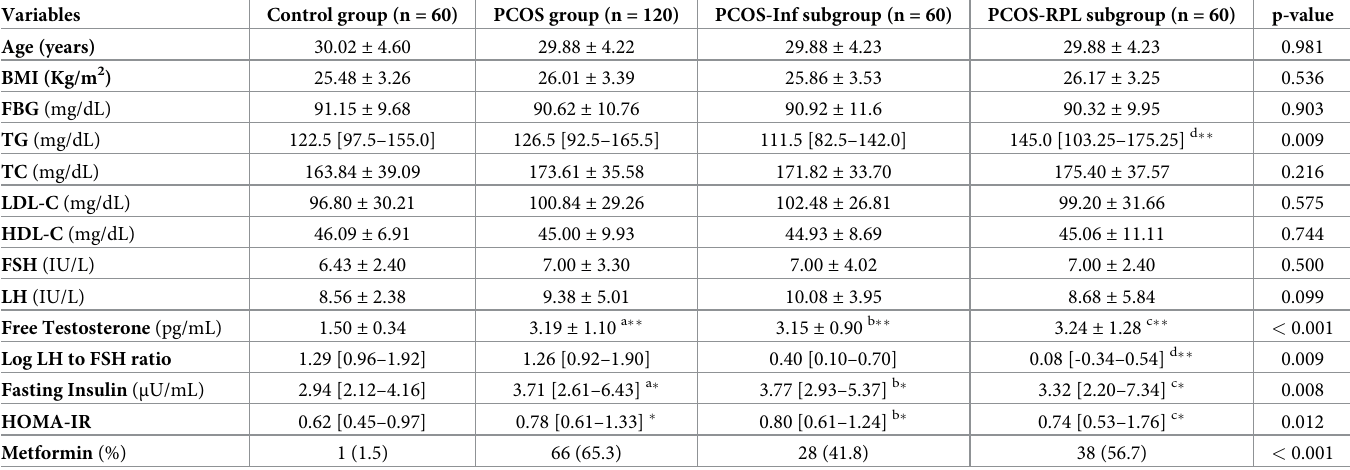
Table 1. Clinical features of the study